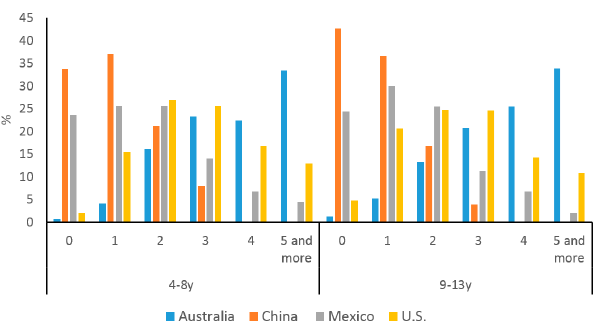
Figure 1. The distribution of snacking frequency among children from Australia, China, Mexico, and the US (%). Color of the bars represents different countries, blue for Australia, brown for China, grey for Mexico, and orange for the US. Notations of 4–8y and 9–13y refer to children 4–8 years of age and 9–13 years of age respectively.